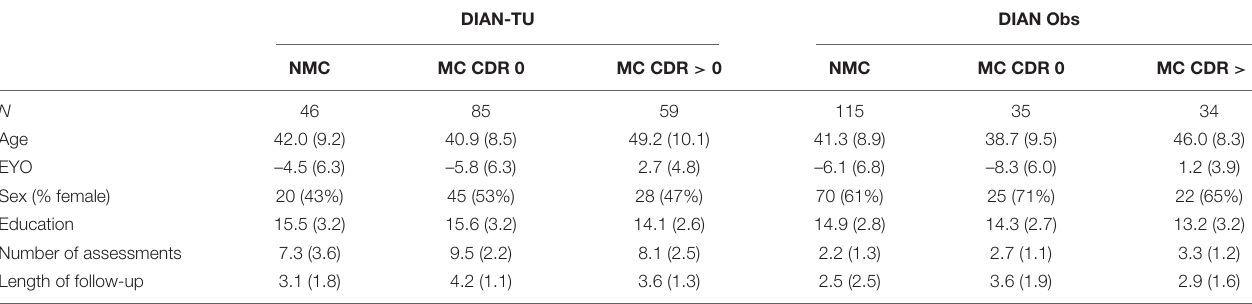
TABLE 1 | Demographic characteristics of the clinical trial (TU) and observational (OBS) study cohorts.